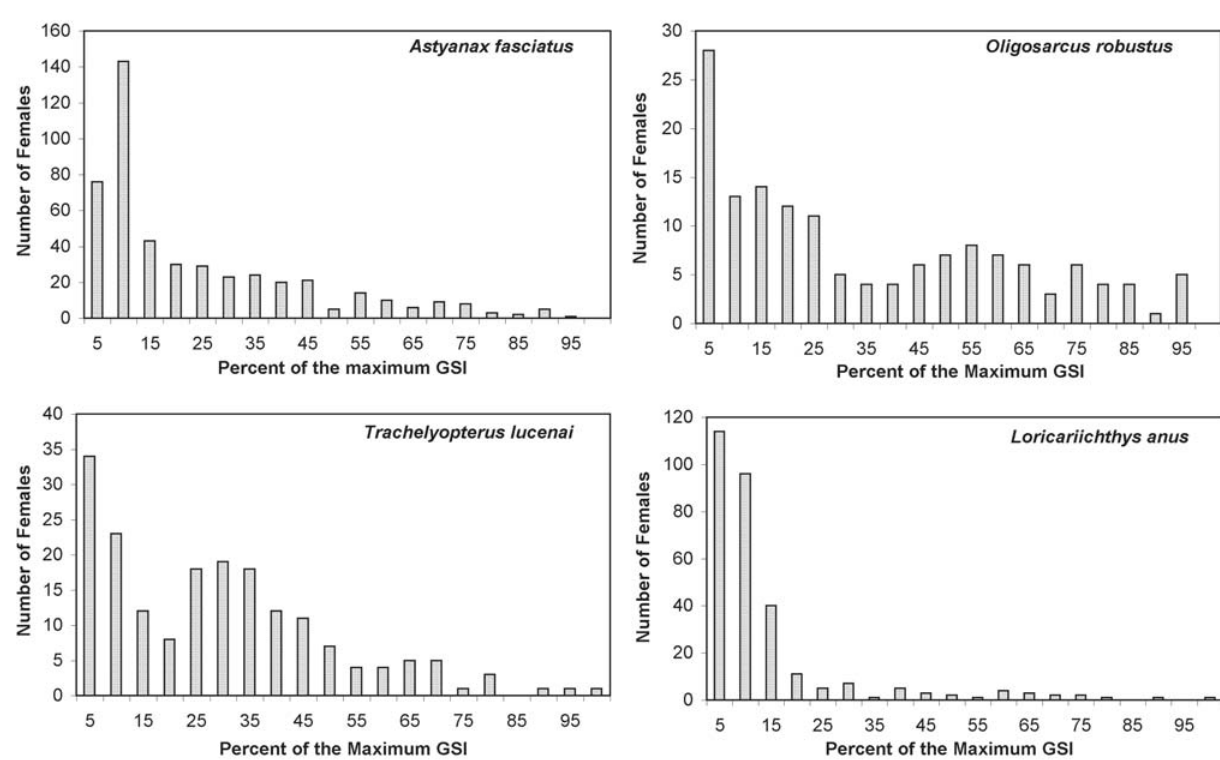
Fig. 4. Frequency distribution of females with individual gonadossomatic index (GSI) as a percentage of the maximum GSI identified for each of the four species. Animals captured using seine and gill nets over 17 monthly samples (November/2002 to May/2004) from two sites (lagoa do Casamento and lagoa dos Gateados, Rio Grande do Sul State,